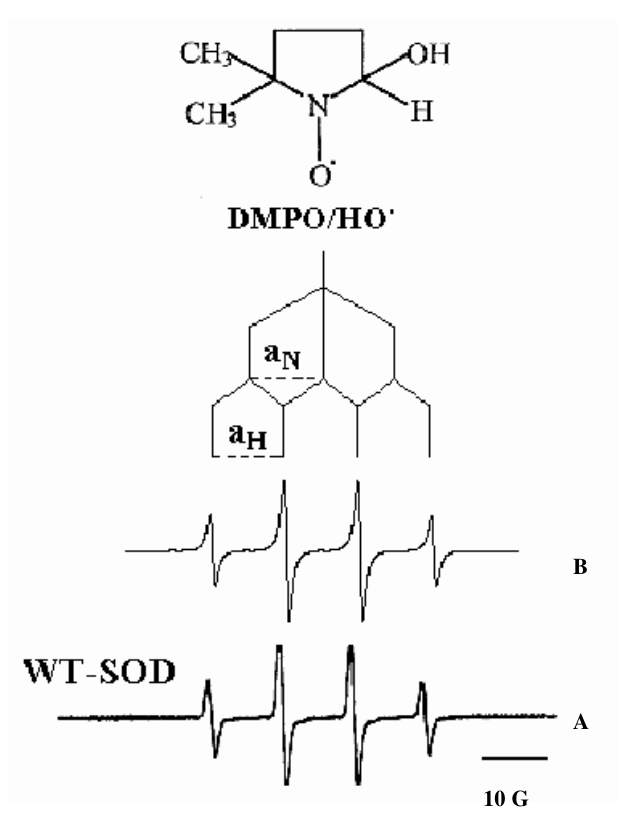
Figure 3. Chemical structure and ESR spectra of DMPO/HO. adduct : (A) Experimental spectrum; (B) Simulated spectrum. The hyperfine coupling constants are provided in